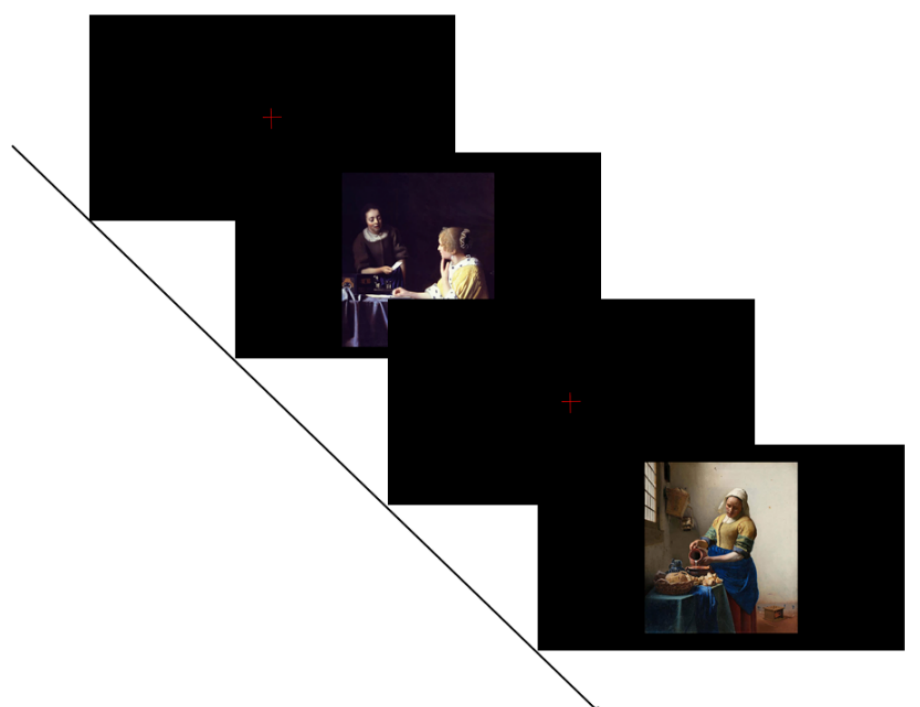
Figure 2. Experimental program example.